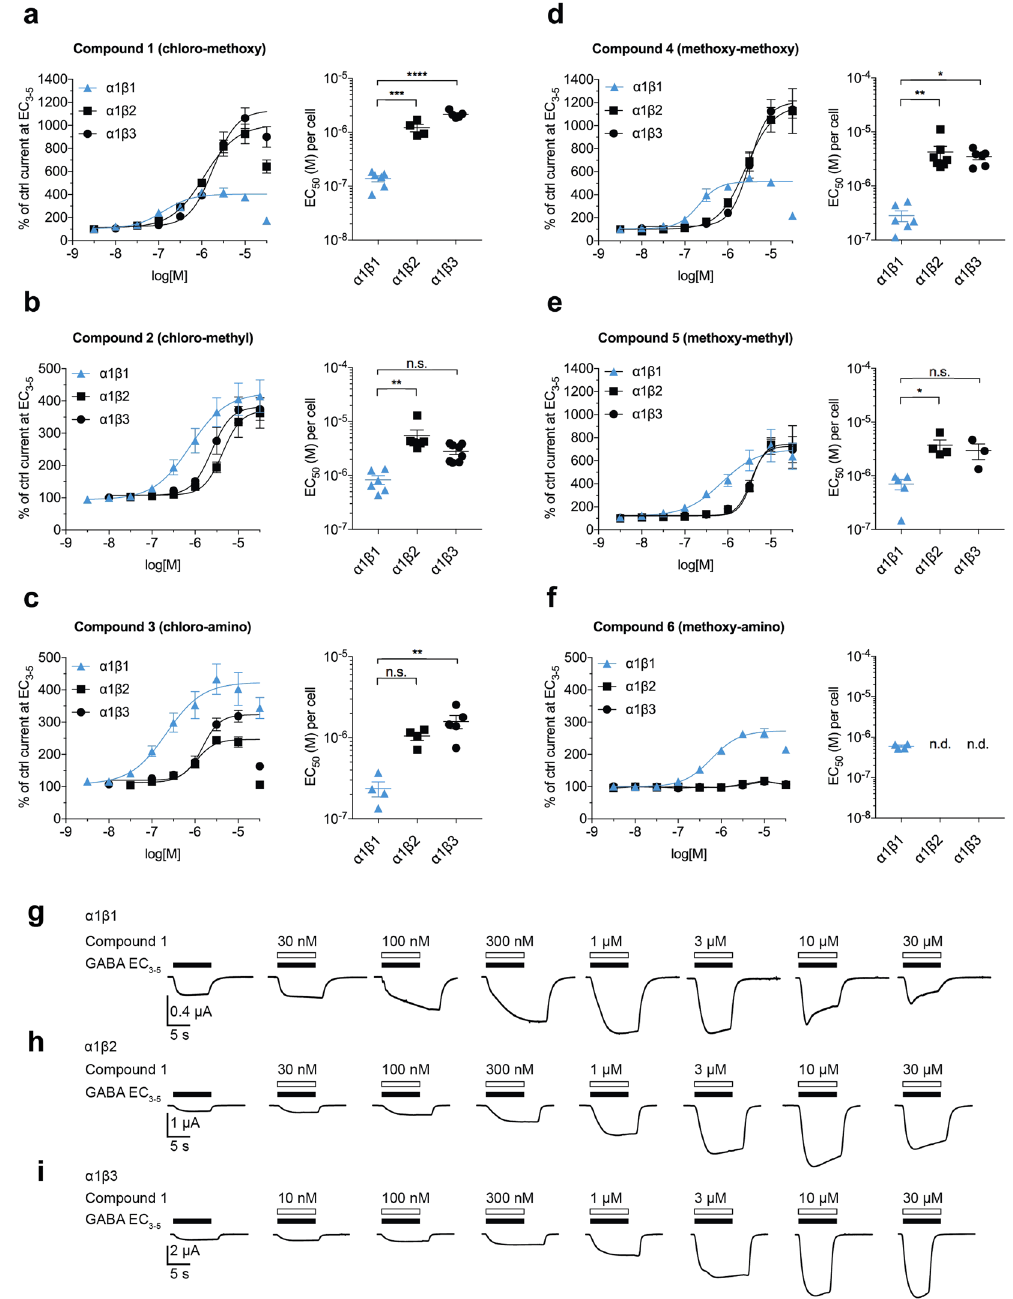
Figure 3. Compounds 1 – 6 show potency selectivity for β 1-containing receptors. Dose-response data of compounds 1 – 6 at α 1 β 1, α 1 β 2 and α 1 β 3 subunit combinations; ( a – c ) Left, aggregate dose-response curves of R 8 = chloro compounds 1 – 3 co-applied with GABA EC 3–5 . Right, EC 50 values obtained by fitting data of each cell individually; ( d – f ) Left, aggregate dose-response curves of R 8 = methoxy compounds 4 – 6 co-applied with GABA EC 3–5 . Right, EC 50 values obtained by fitting data of each cell individually. Highest potency was consistently observed at α 1 β 1 receptors. Compound 6 ( f ) lacked efficacy at α 1 β 2 and α 1 β 3, therefore EC 50 values could not be obtained. In those instances where high compound concentrations elicited substantial desensitization (see panels a , c , d , f and sample traces in ( g,h )), the highest compound concentration was excluded from the fit. Statistically significant differences were assessed by one-way ANOVA with Tukey’s multiple comparison test; * p < 0.05, *** p < 0.01, **** p < 0.001, ***** p < 0.0001, n.s. = not significant, n.d. = not determined. n = 3–8. ( g – i ) Sample traces obtained with compound 1 . Note the desensitization in α 1 β 1 ( g ) at 10 µ M and 30 µ M, increasingly limiting maximum current amplitudes. Tabulated data corresponding to panels a – f are provided in Supplementary Tables S1–S6. Additional sample traces are provided in Supplementary Fig.